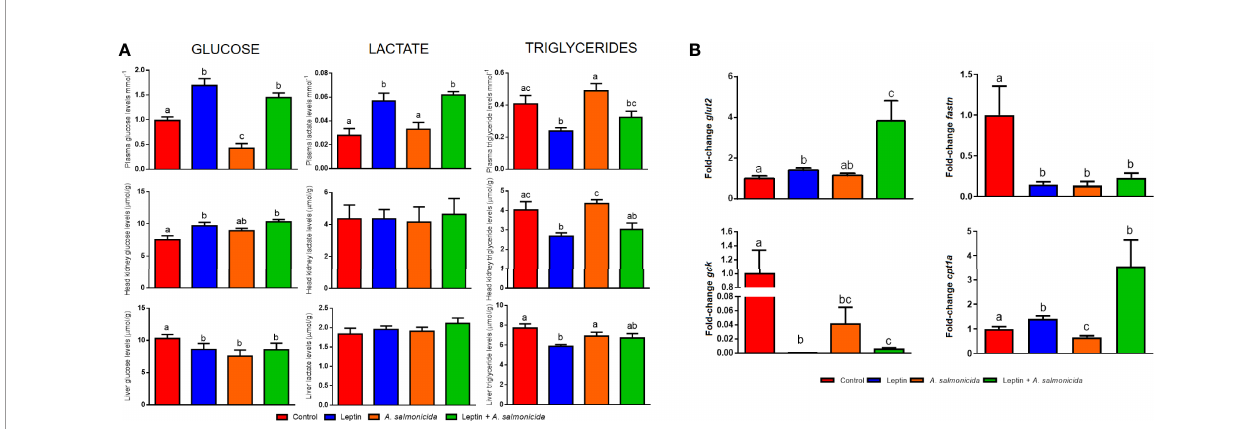
FIGURE 7 | Measurement of metabolic regulation induced by leptin and A salmonicida . (A) Levels of glucose, lactate and triglycerides in plasma, head kidney and liver, and (B) gene expression analysis of glut2 , gck , fasn and cpt1a in liver of turbot chronically treated with leptin in the absence or presence of infection. Fish were sampled at 24 hpi, where 8 individuals were used for assessment of the metabolite levels and 6 fi sh were used for gene expression analysis. For the gene expression data, the expression level of each gene was normalized to the expression of eef1a and expressed as the fold-change with respect to the levels detected in the control group. Graphs represent the mean + SEM of 8 or 6 fi sh per treatment, respectively. Different letters indicate signi fi cant differences (p < 0.05) among